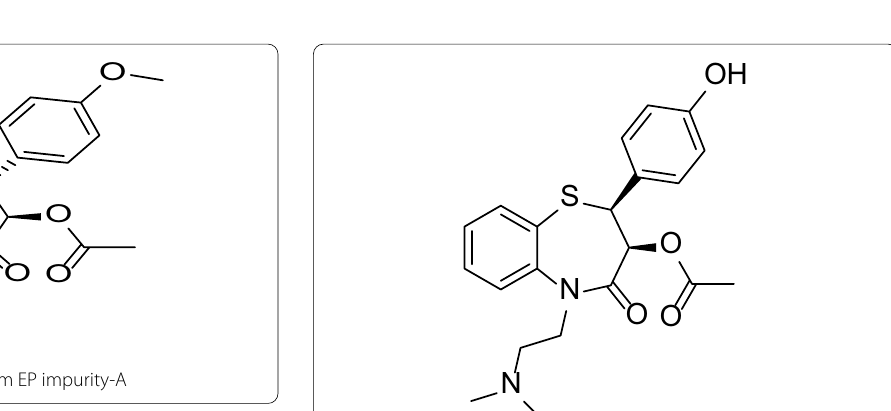
Fig. 4 Chemical structure of diltiazem EP impurity-C